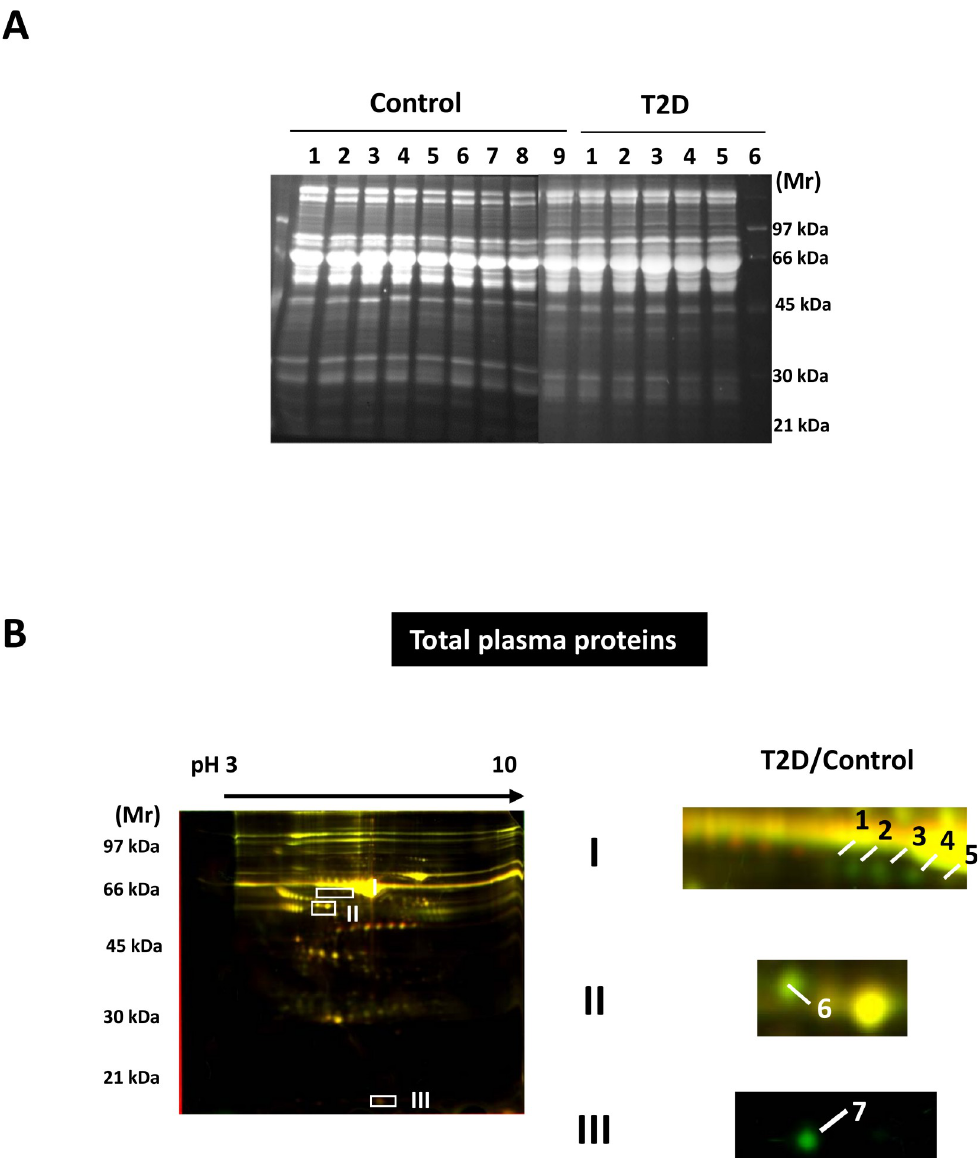
Fig 2. Differentially expressed proteins expressed in the serum proteomes of the control and T2D rats. (A) 1-DE analysis of the sera before pooling. Proteins (30 mg) were subject to analysis using 12.5% SDS-PAGE gels. Gels were stained with SYPRO Ruby as described in the experimental procedures. (B) The overlaid 2-D DIGE images for the control and T2D serum pools. Proteins from the control and T2D serum pools (50 mg) were labeled with Cy3 and Cy5, respectively, and mixed for 2-DE analysis as previously described. Greenish (Cy3) and reddish (Cy5) spots indicate differentially expressed proteins in the control and T2D serum pools